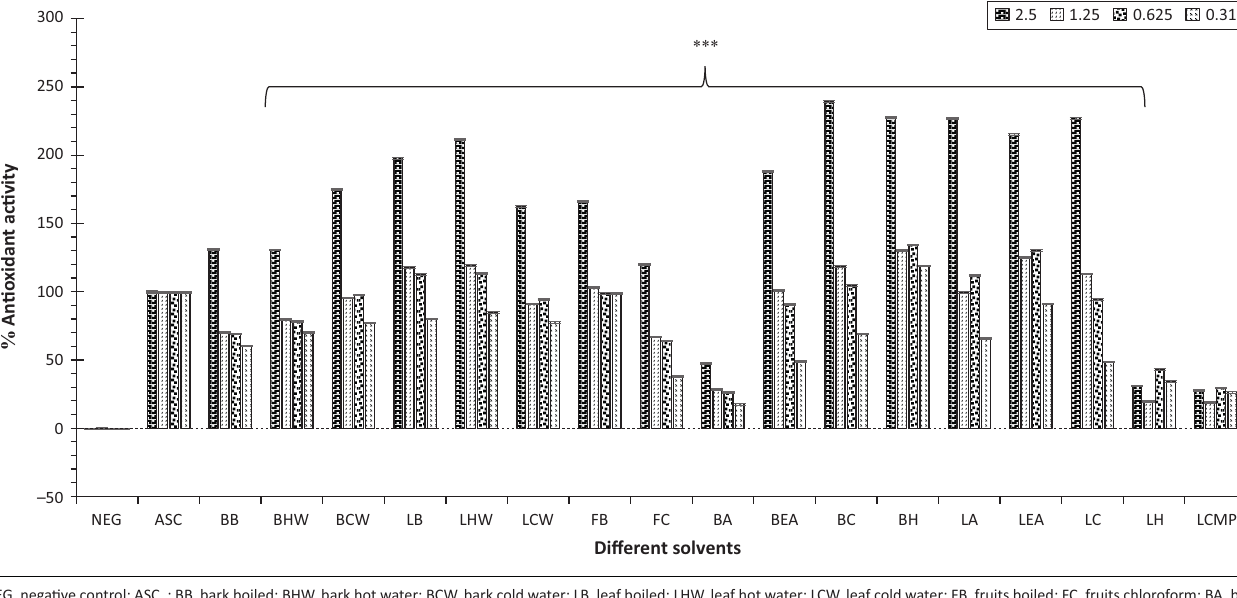
FIGURE 3: Radical scavenging of the different extracts of C. grandicalyx with ascorbic acid as the positive